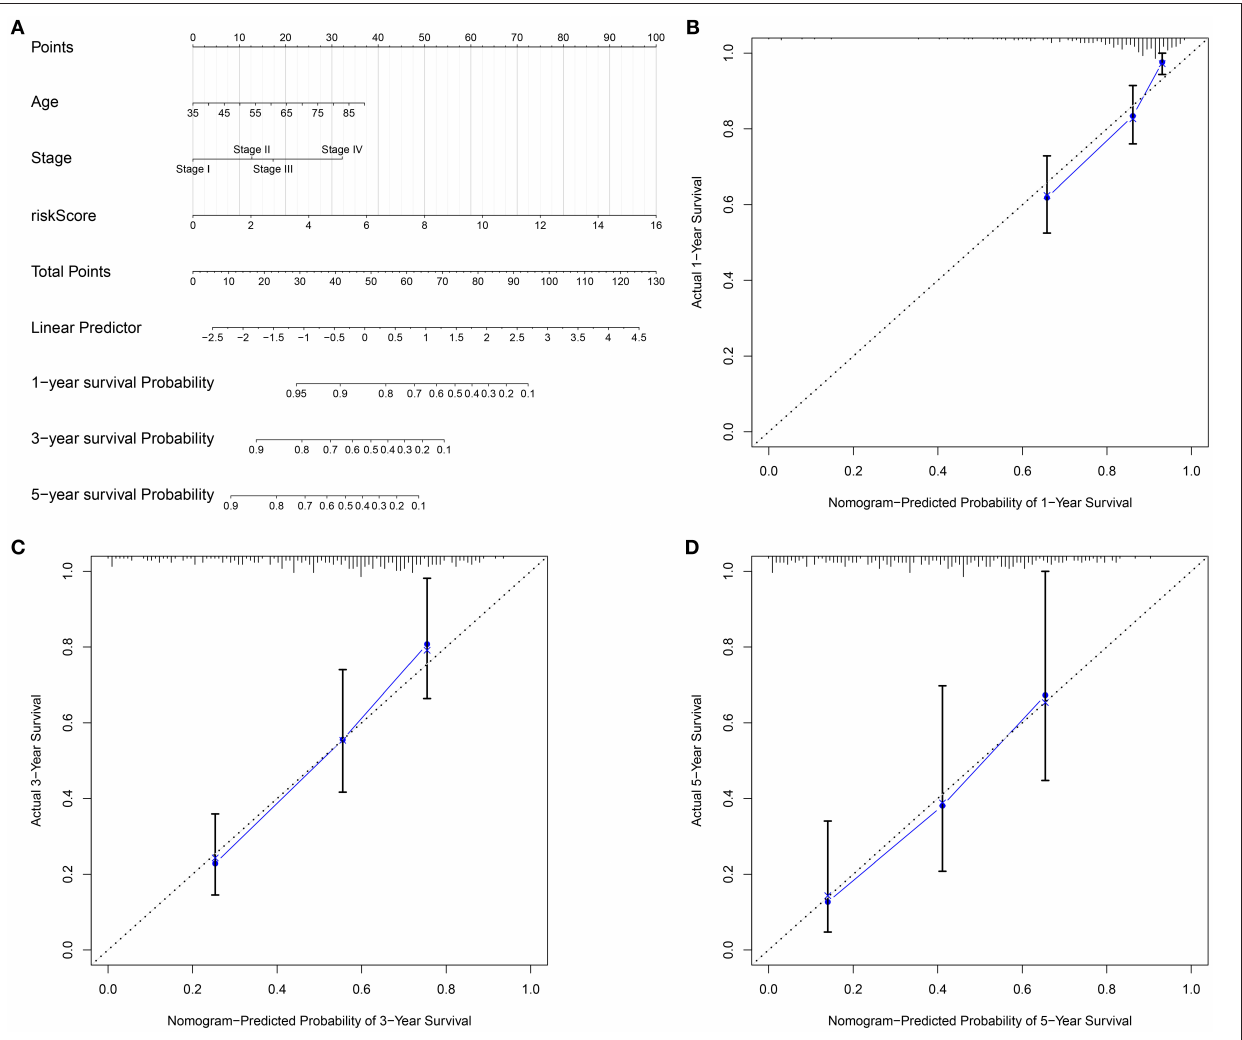
FIGURE 8 | Establishment of a nomogram for gastric cancer in the training set. (A) A nomogram integrating age, stage, as well as signature in prediction of 1-, 3-, and 5-year outcomes in gastric cancer. The calibration curves for the relationships between (B) 1-, (C) 3-, and (D) 5-year survival predicted by this nomogram and actual clinical